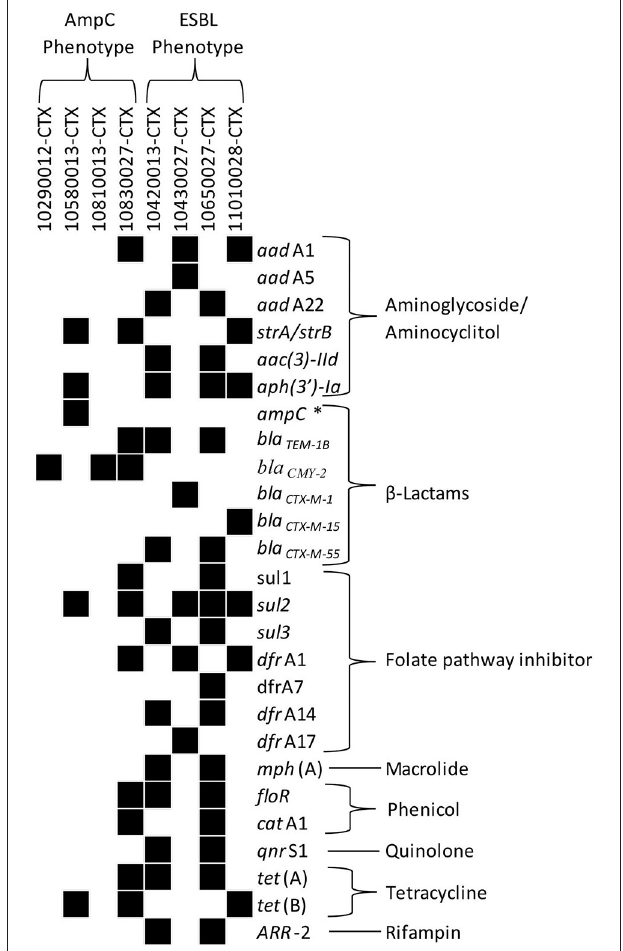
FIGURE 6 | Antimicrobial resistance gene profiles of randomly selected ESBL ( n = 4) or AmpC ( n = 4) producing Escherichia coli isolated from calf or cow feces or manure pit of 101 dairy farms in Québec, Canada. Isolates were recovered using a selective protocol. Whole genome sequencing of selected isolates was processed on Resfinder and PointFinder in the Center for Genomic Epidemiology (CGE) to determine the presence of antimicrobial resistance genes. Black blocks indicate the presence of the corresponding gene. Antimicrobial classes associated with resistance genes are listed in the column to the right of the gene names. *Promoter mutation in ampC -42C - >